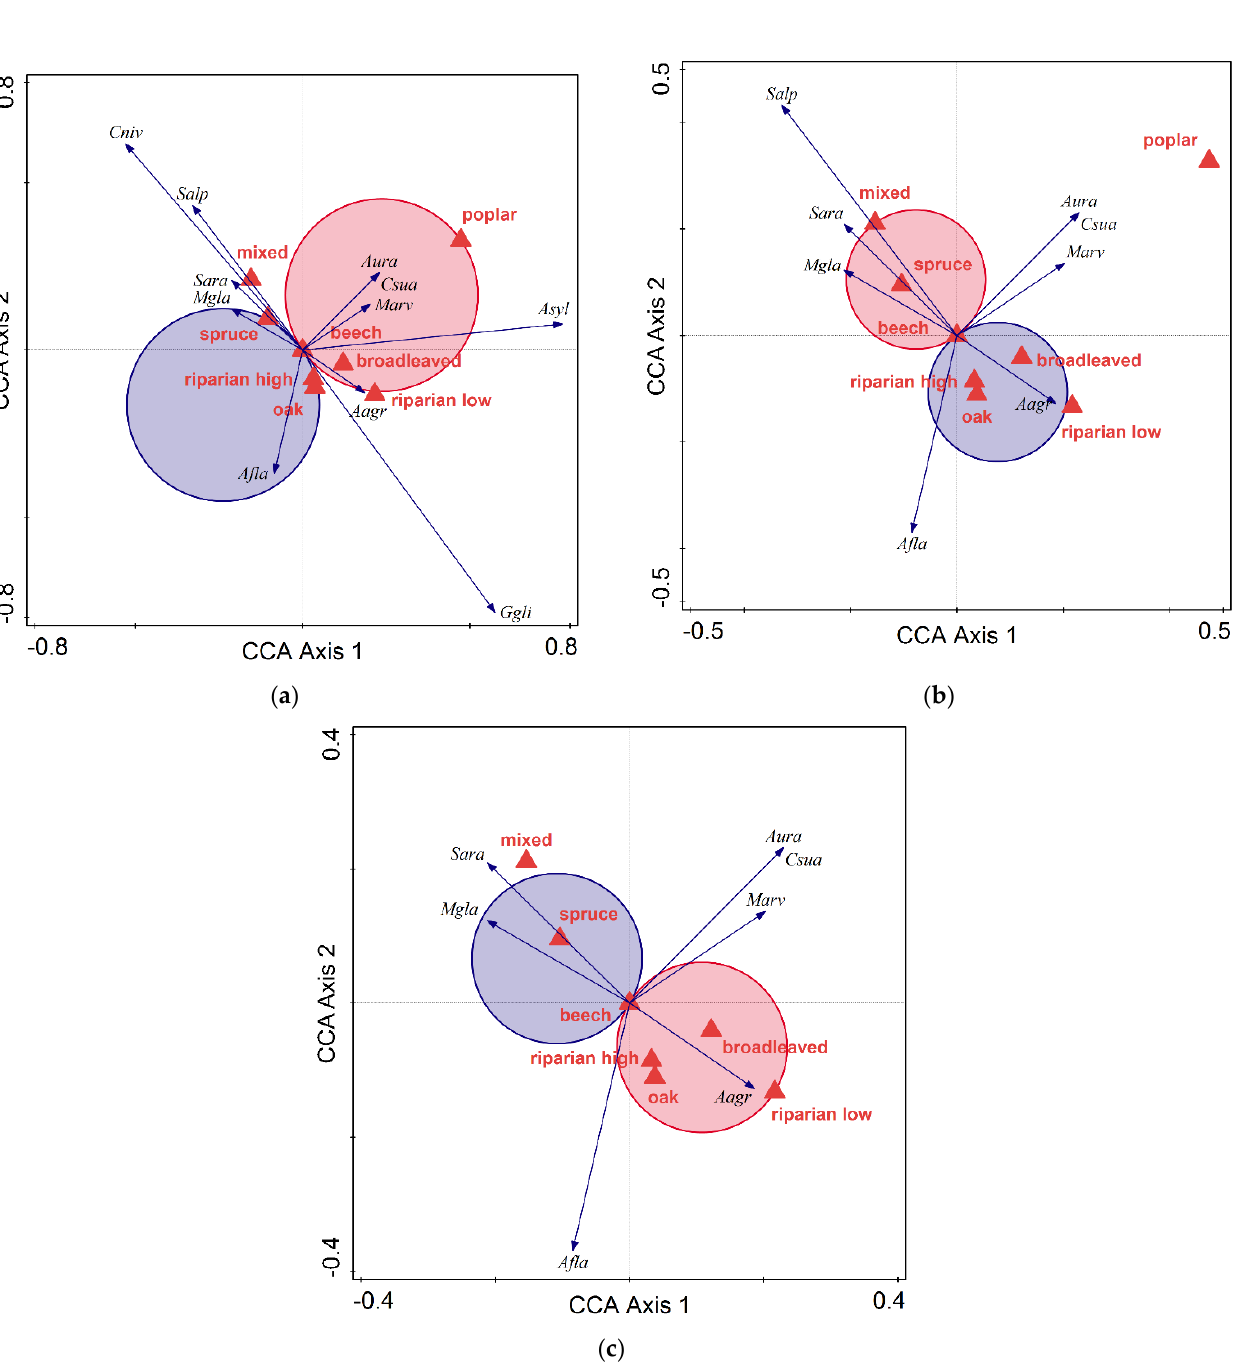
Figure A1. The t-value biplots, displaying the first two CCA axes with Van Dobben circles drawn for the forest types with a significant effect on species composition: ( a ) poplar forest, ( b ) mixed forest, ( c ) riparian forest in lowland. Species indicated by arrows ending inside the pink circle show a positive significant response to that forest type at p = 0.05, having increased relative abundance, while the species indicated by arrows ending inside the blue circle show a negative response, significant at p = 0.05, the response being stronger when arrows are shorter. For the other species, relative abundance was not significantly related to forest type.